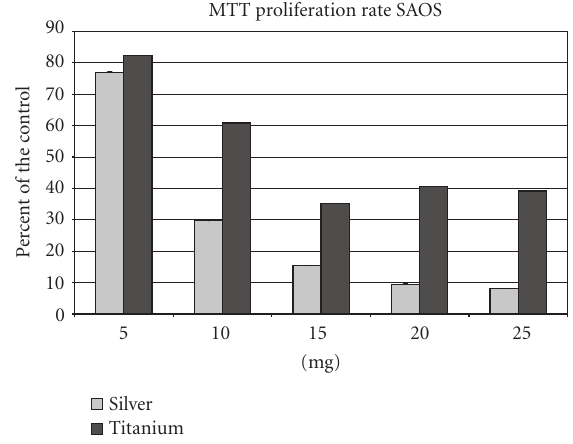
Figure 2: Alkaline phosphatase activity of the HOS-58 cell line after supplementation of 5–25 mg silver or titanium.